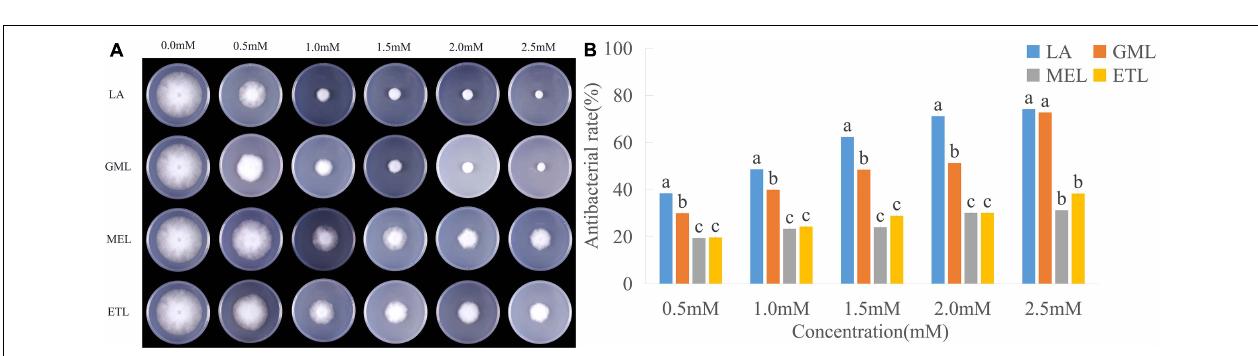
FIGURE 2 | Inhibitory effects of lauric acid (LA) and its derivatives to P. sojae . (A) The mycelia of P. sojae (Race2) were cultured on media containing LA, glycerol monolaurate (GML), methyl laurate (MEL), or ethyl laurate (ETL) for 5 days. (B) The diameter of each colony was measured and statistical analyzed via software Statistical Product and Service Solutions (SPSS). Means with different letters are significantly different ( p < 0.05).